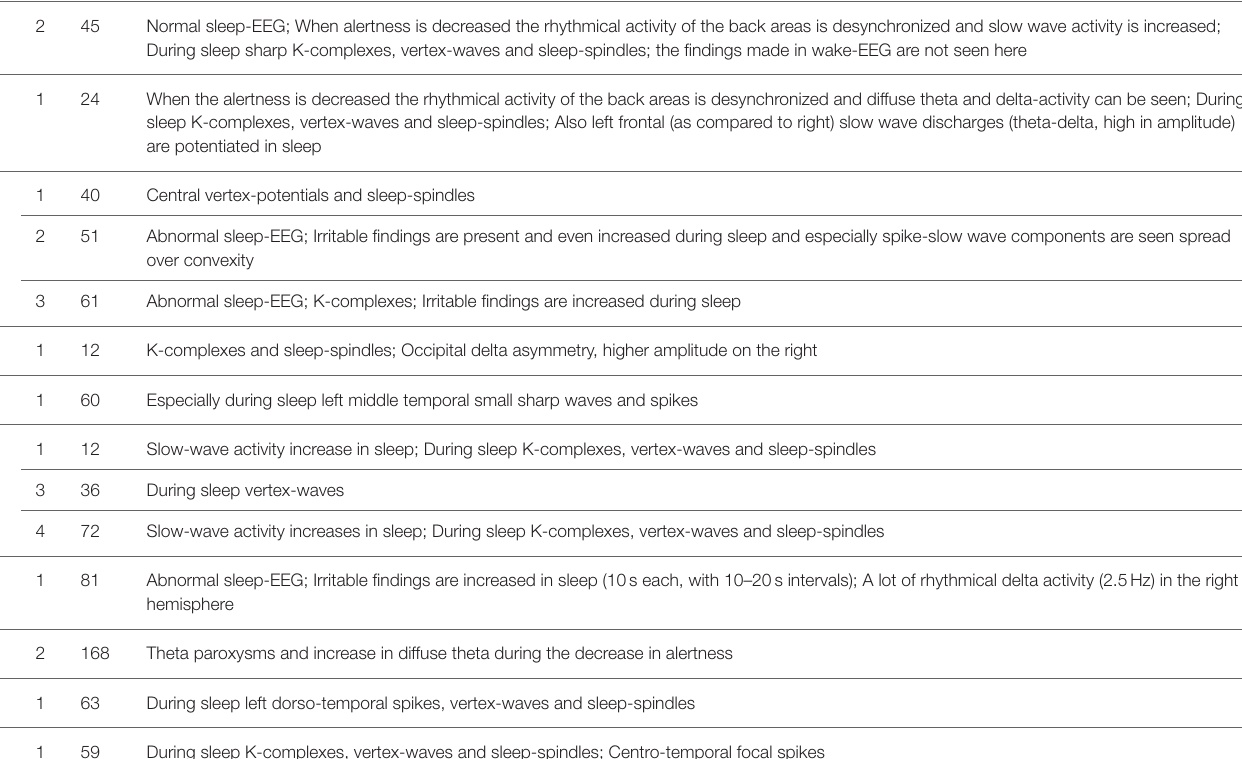
During sleep K-complexes, vertex-waves and sleep-spindles; Centro-temporal focal spikes